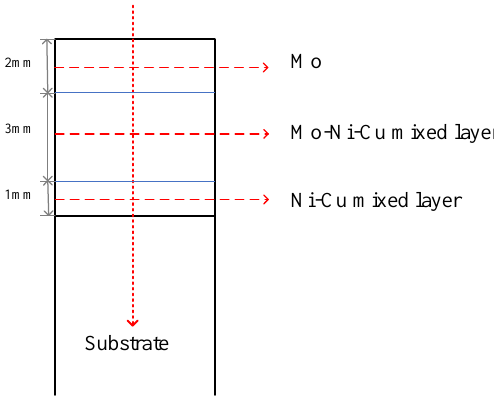
Figure 2. Schematic diagram of hardness measurement